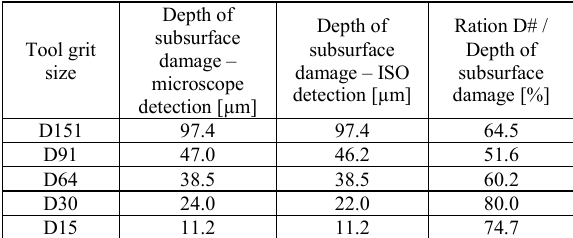
Table 5 . Depths of the subsurface damege inspected by microscope and ISO controle and ration between grit size and subsurface